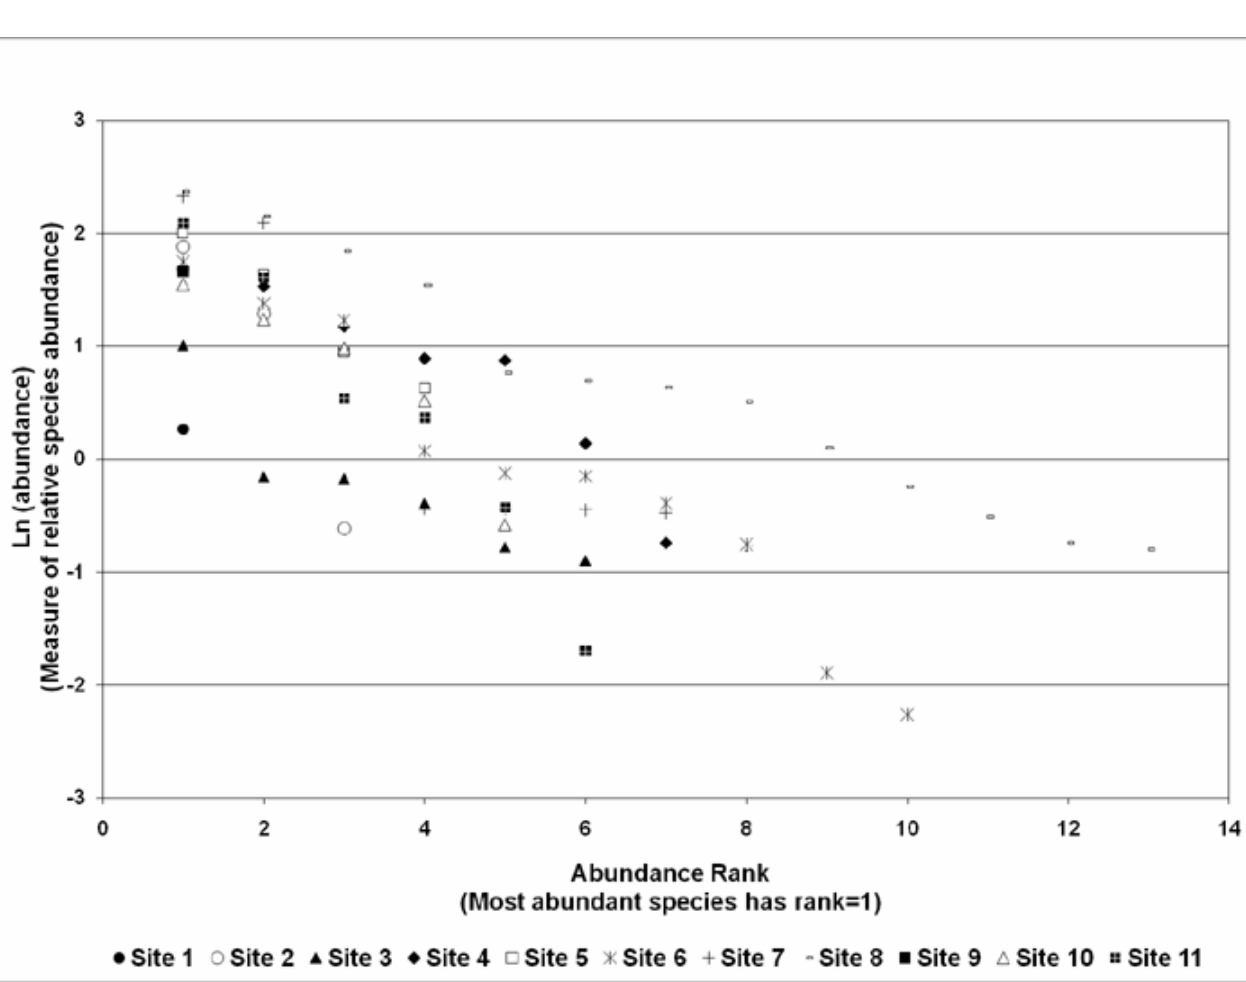
Fig. 5. . Plot-scale (dbh>5 cm) dominance-diversity curves in enriched